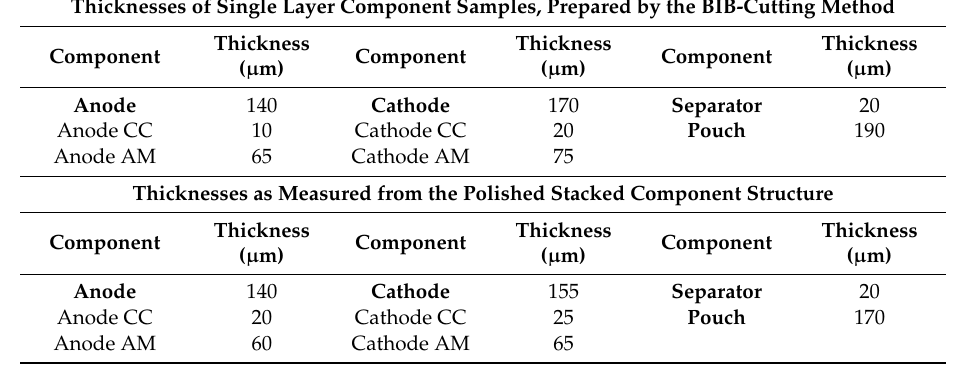
Table 1. Table containing values for the measured thicknesses of all battery components prepared using the broad-ion-beam (BIB) cutting and mechanical polishing